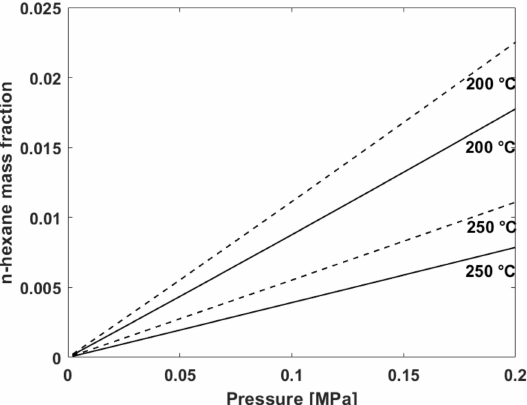
Figure 2. Comparison between the model prediction of n-hexane solubility isotherms in V8880 at T = 200 ◦ C and T = 250 ◦ C, carried out respectively assuming k 12 independent on T (“athermal”, dotted line) and k 12 linearly dependent on T (“linear”, solid